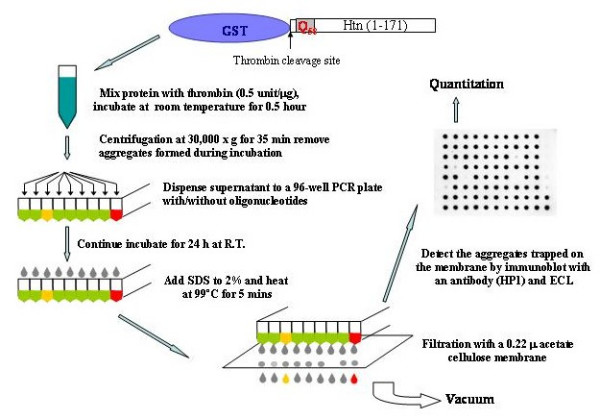
Diagram of the biochemical model screening assay. This diagram is taken from Wang et al. (2005) and illustrates the steps involved in the biochemical/immunoblotting assay used in this paper. The fusion protein GST-Q58-Htn (20 μg/ml) was mixed with thrombin (0.5 unit/μg protein) for 30 minutes and the mixture centrifuged to remove aggregated protein. The soluble protein was mixed with an oligonucleotide in a 96-well PCR plate and incubated for 24 hours at room temperature (RT). SDS was added to a final concentration of 2% and the mixture heated at 99°C for 5 minutes. Filtration through a 0.22 micron acetate cellulose membrane filter was followed by detection of aggregated Q58-Htn fragment by immunoblotting with an antibody (HP1) and ECL. Quantitation was carried out using an ImageQuant program. The blot displays both positive and negative results – positions lacking a black spot indicate that aggregation was inhibited by the oligonucleotide.